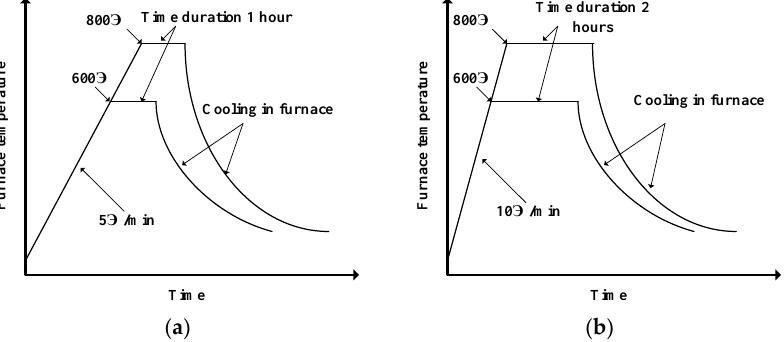
Figure 5. Schematic diagram of the heating rate of the high-temperature furnace: ( a ) 5 and ( b ) 10 °C/min.